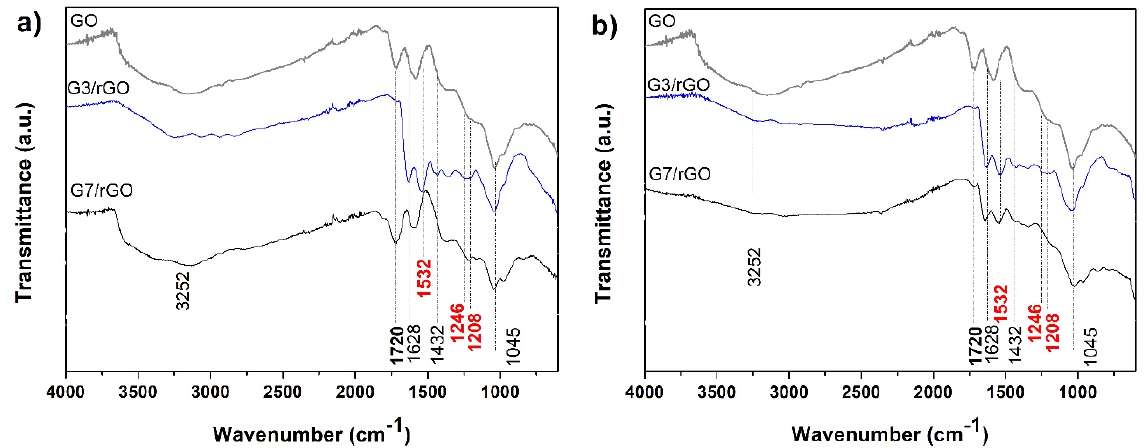
Figure 6. FTIR spectra of the PAMAM-modified rGO aerogels obtained at T HT of ( a ) 110 °C and ( b ) 140 °C.